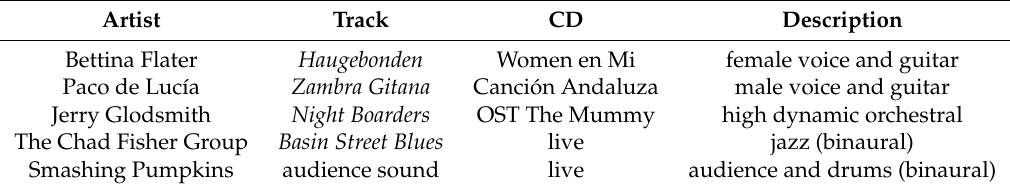
Table 1. Music program used for listening Tests 2 and